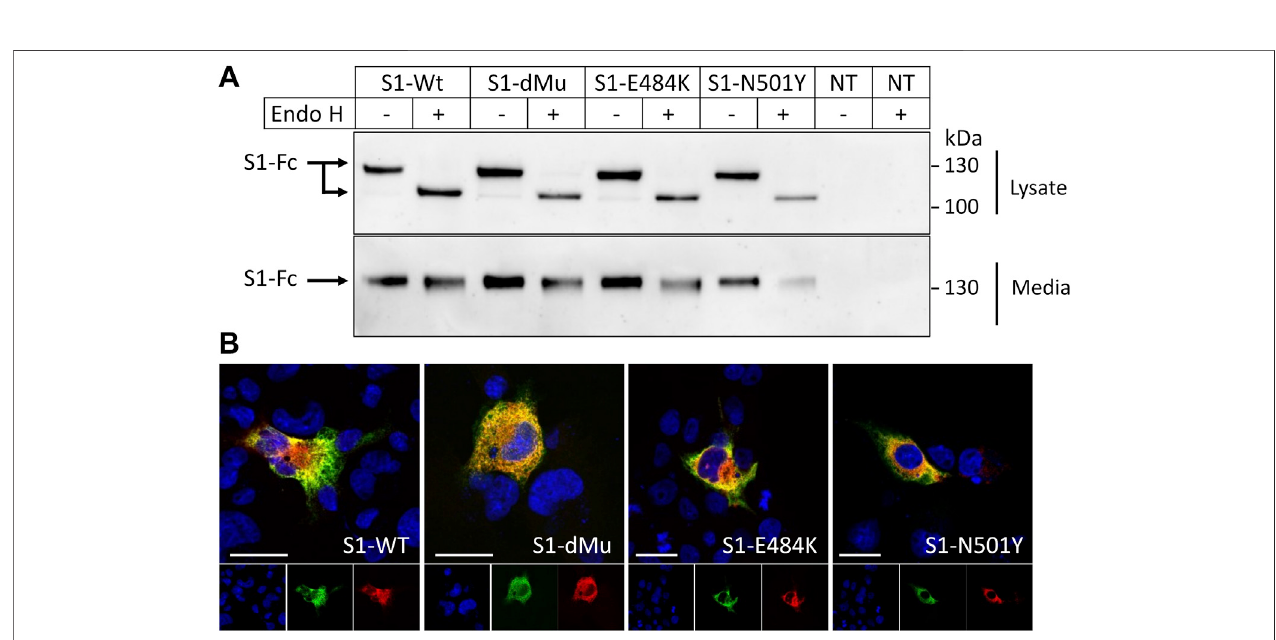
FIGURE 2 | Characterization of subcellular and secretory forms of spike S1 proteins. (A) COS-1 cells were transiently transfected or non-transfected (NT) with plasmidsencodingWt-S1,dMu(L452andE484),E484K,andN501YS1mutations.After48 hoftransfection, proteins wereimmunoprecipitatedfrombothcelllysates, and media were then treated or not treated with Endo H. Cellular and secretory S1 proteins were immunoprecipitated and analyzed by Western blot. The upper panel showsa130-kDaproteinthatshiftedtoalowermolecularweightfollowingEndoHtreatment. (B) SubcellularlocalizationofS1variantsinthetransientlytransfected COS-1 cells. S1-Wt and mutant proteins were expressed in the COS-1 cells grown on coverslips, and their subcellular localization in the ER was investigated by immuno fl uorescence and visualized by confocal microscopy. The cGRP94 plasmid that encodes the ER chaperone GRP94 was used as an ER marker. Scale bars, 10 and 20 μ